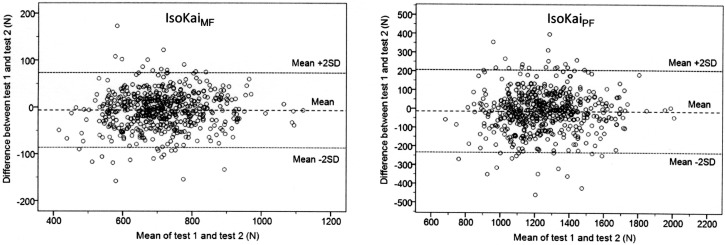
The mean of test 1 force and test 2 force plotted against the difference between the test 1 force and test 2 force in the intrarater sample.IsoKaiMF, IsoKai mean force (N); IsoKaiPF, IsoKai peak force (N); LOA, limits of agreement.